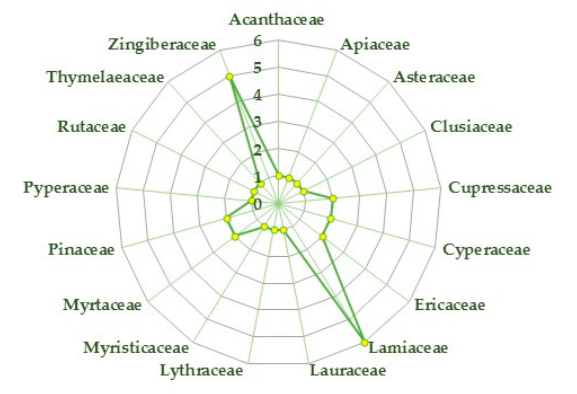
Figure 1. Number of plant species whose essential oils (EOs) showed antiarthritic potential for the ff erent different families. di